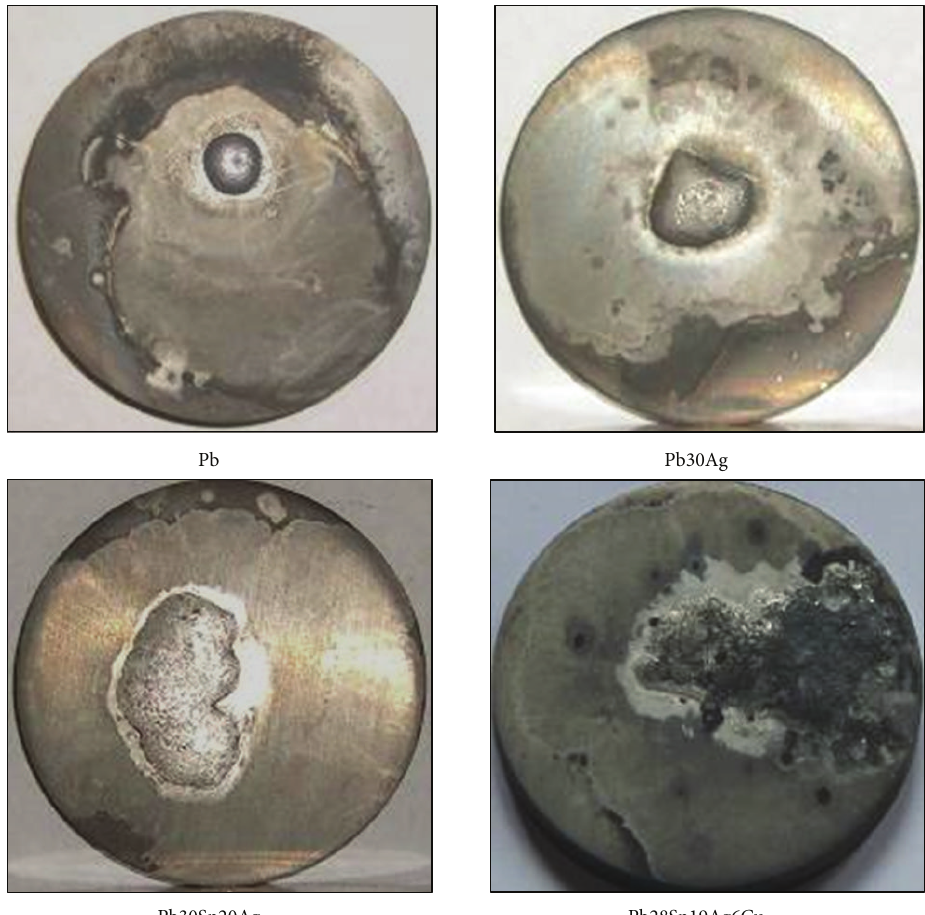
Figure 4: Wetting ability of the soft alloys with different compositions on the ceramic composite surface (𝜙58) .